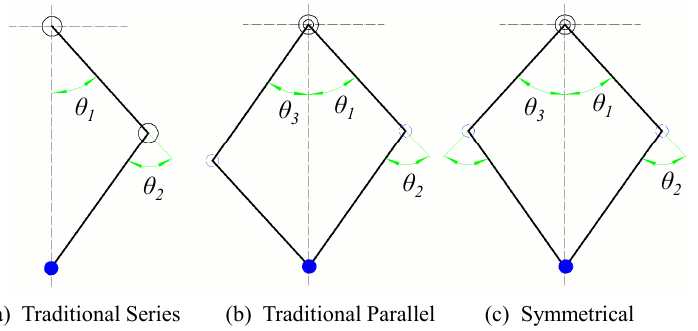
Figure 1. Three leg structures: ( a ) Traditional series (TS), ( b ) traditional parallel (TP) and ( c ) symmet- rical leg